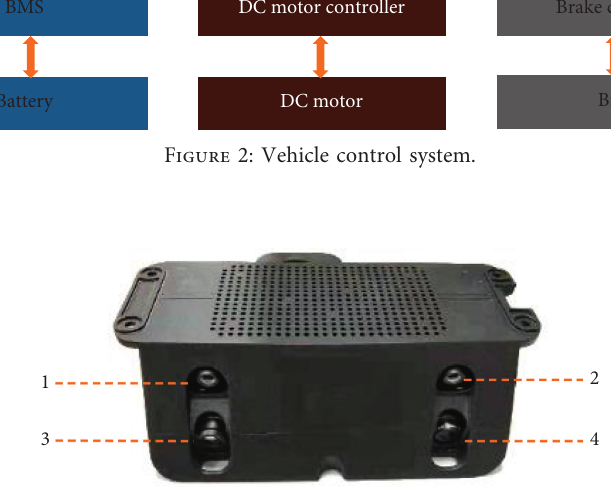
Figure 3: Smart B1 camera